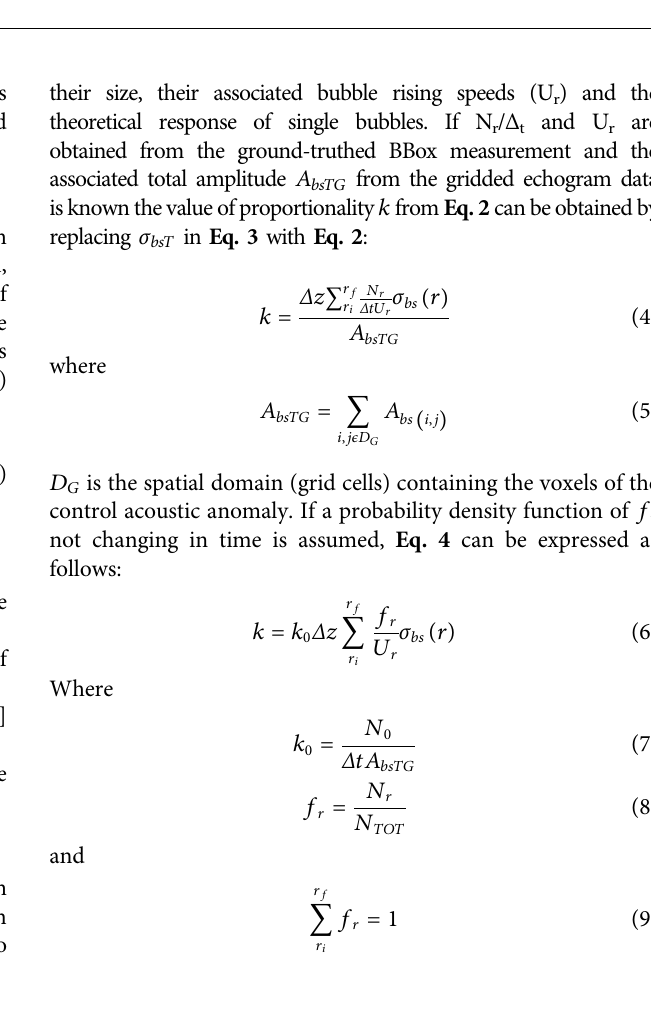
FIGURE 3 | Schematic of experimental setup for parallel GasQuant and BBox measurements at the study area. The image includes the idealized gridded- interpolated echo-fan used for the calculation of the representative un-calibrated amplitudes A bsT of a single bubble-stream. The graph indicates that each voxel has its speci fi c un-calibrated backscatter value A bs ( i , j )